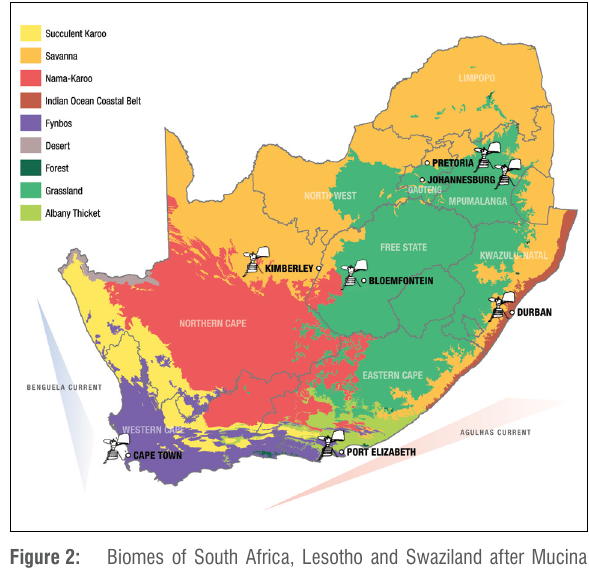
Figure 2: Biomes of South Africa, Lesotho and Swaziland after Mucina and Rutherford 10 , with oceanic currents which trigger climate (blue arrow: Benguela Current; red arrow: Agulhas Current). Dots show cities covered by SAPNET since August